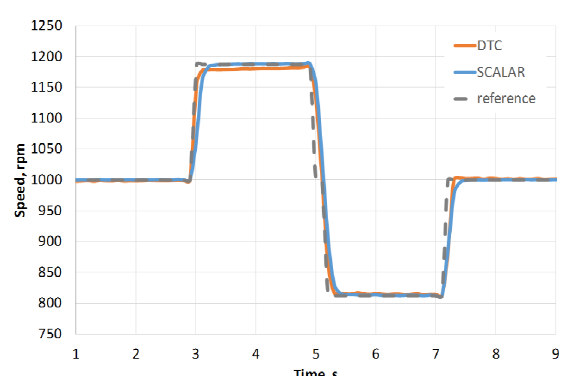
Fig. 5. Drive speed response profile around 1000 rpm at meander test cycle.